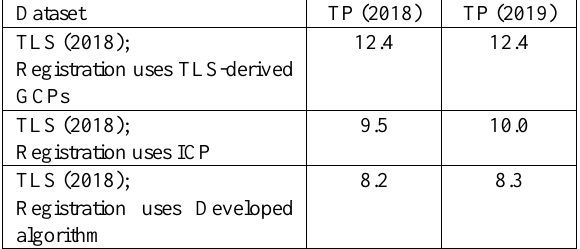
Table 2. Glenwood Canyon site. Registration RMSE values (in cm) for the TP datasets using the TLS 2018 as basis for the